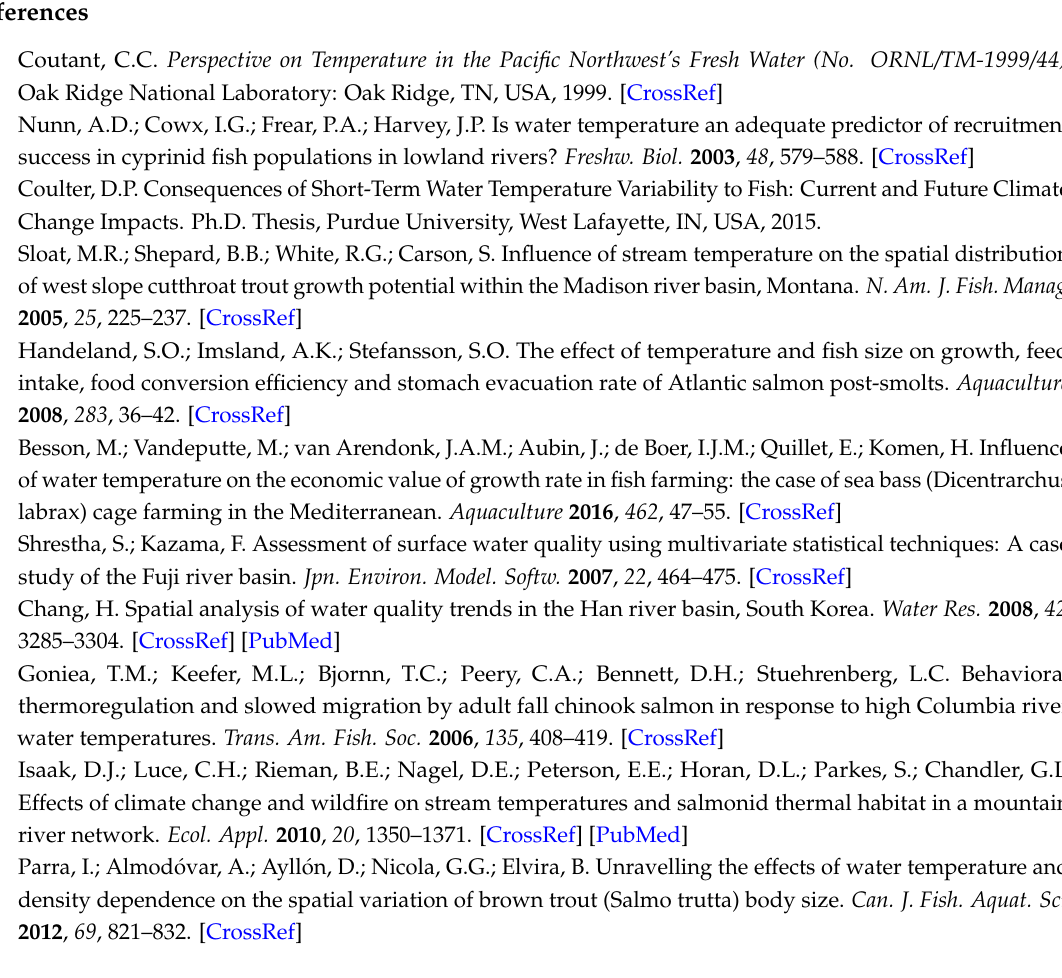
Figure S1: Quantile mapping results of maximum temperature for each month with CanESM2 and RCP 2.6 scenarios, Figure S2. Boxplot of monthly median air temperature from 2020 to 2096 years for RCP 2.6 with 9 climate models; bold red line indicate monthly median temperature for observed period (2011 to 2014), Figure S3. Boxplot of monthly median air temperature from 2020 to 2096 years for RCP 4.5 with 12 climate models; bold red line indicate monthly median temperature for observed period (2011 to